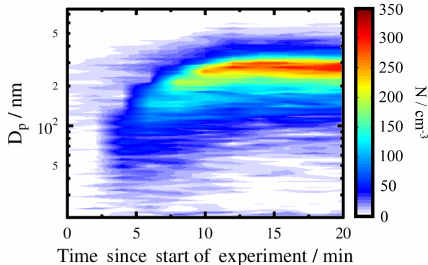
Figure 1. Example wall-loss-corrected SOA growth curve for γ - terpinene + NO 3 in the absence of seed aerosol. The color scale represents aerosol number concentration, N (cm − 3 )